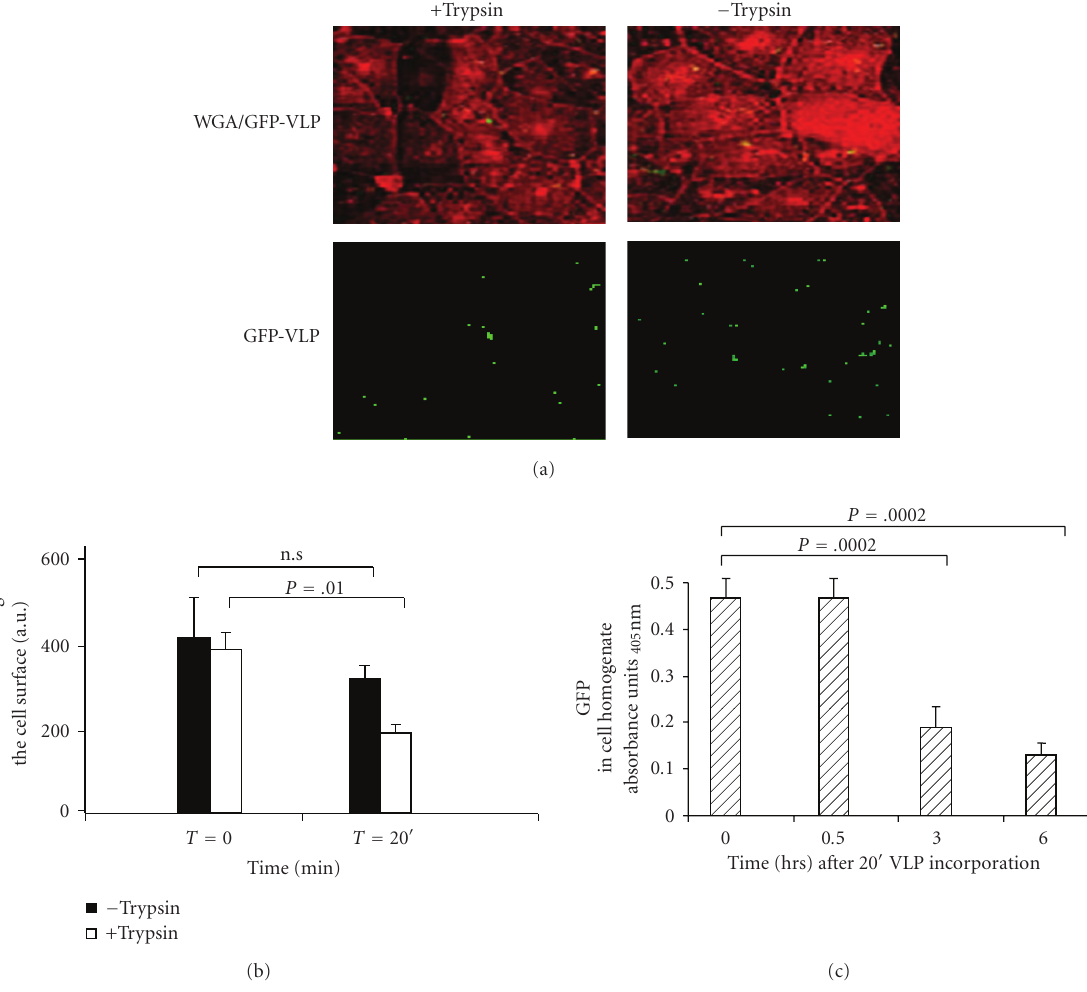
Figure 3: E ffi ciency of VLP internalization in intestinal epithelial cells in vitro. (a) Fluorescence microscopy of MA104 cells after 20-minute exposure to complete GFP-VLP (green label) treated or not with trypsin. MA104 cell surface was labeled using WGA lectin (red label). A representative image of 5 independent experiments is shown. (b) Internalization was quantified by measuring the GFP fluorescence at the cell surface using the built-in Leica software. Results are expressed as the amount of GFP fluorescence (a.u.) at the cell surface as a function of time. Results are means of 5 independent experiments. (c) Detection of GFP within cell homogenates using ELISA assay. GFP amounts were determined immediately after the initial 20-minute interaction between cell and GFP-VLP (time 0) and then for the indicated times. Samples were tested in triplicate in two independent experiments. Results are expressed as the mean absorbance value ± standard deviation